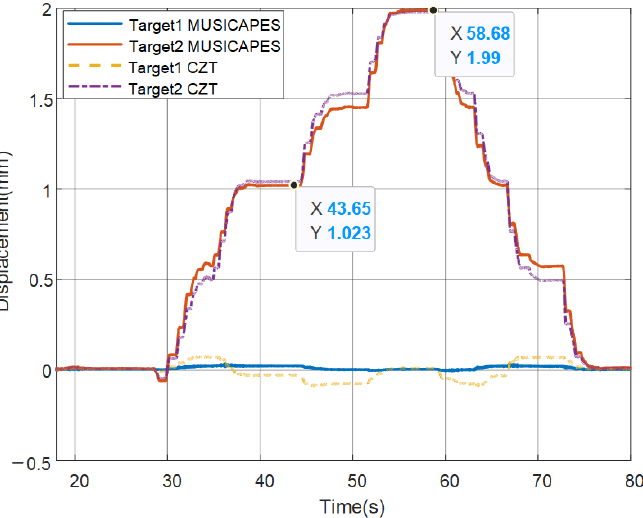
Figure 15. Displacement curves of the two trihedral reflectors estimated by the MUSICAPES and the CZT method. Target 1 is the still reflector and Target 2 is the moving one mounted on the sliding platform.